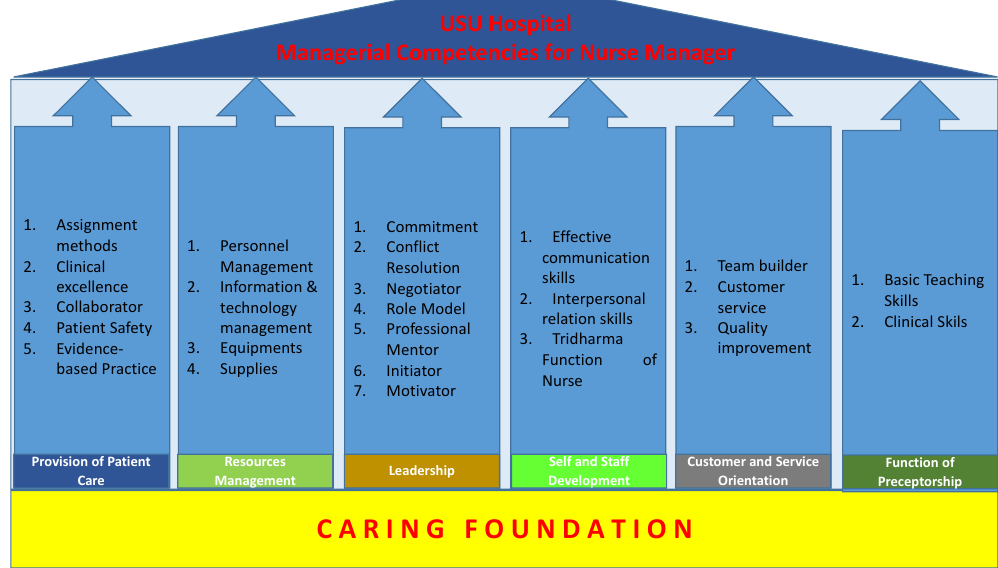
Figure 1. Proposed Nurse Manager Competence Model at Universitas Sumatera Utara